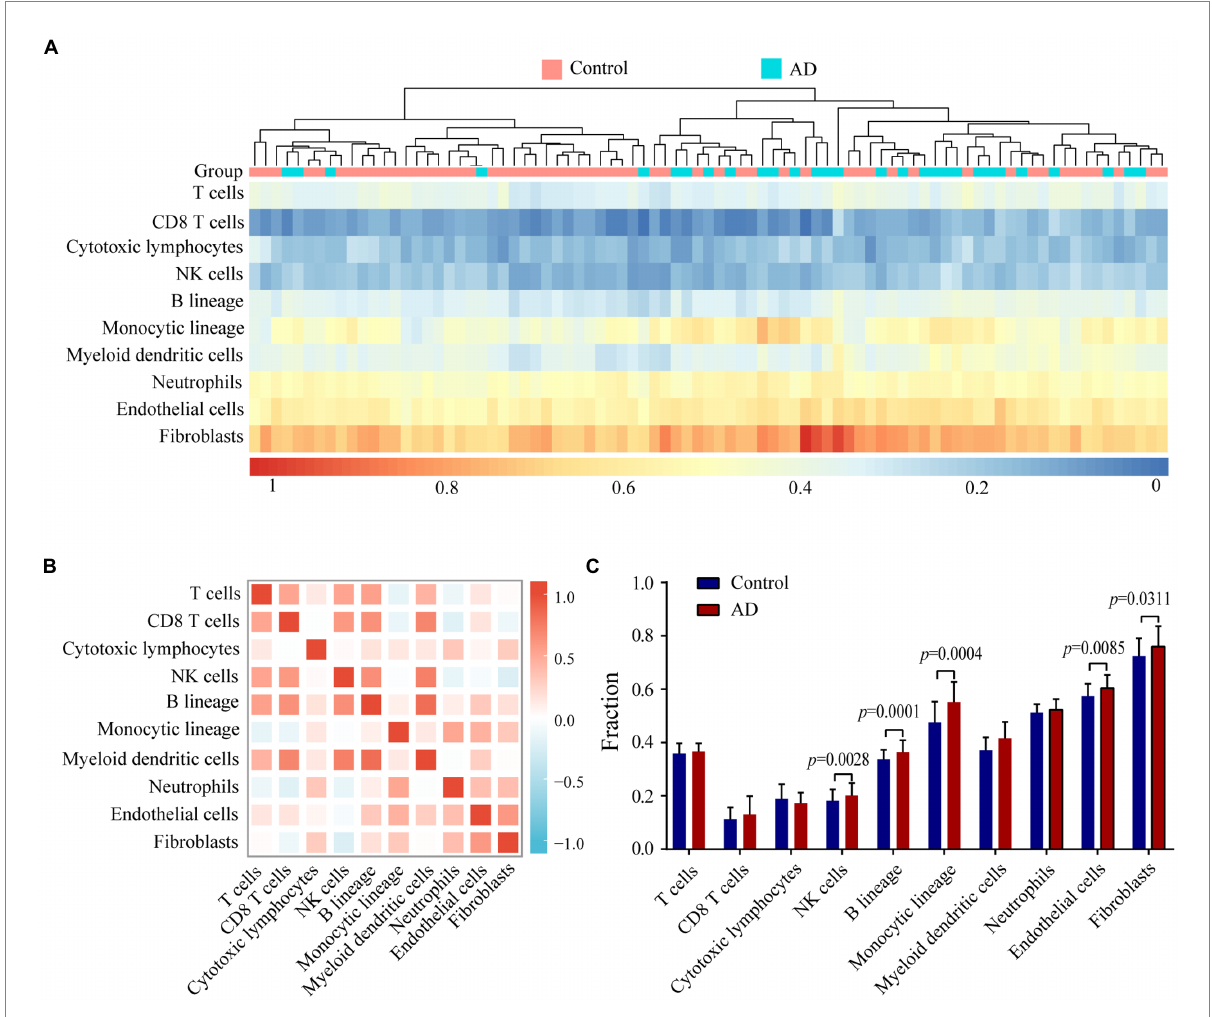
FIGURE 7 Evaluating and identifying the AD immune microenvironment. (A) Heat map presenting results of 8 types of immune cells and 2 types of non- immune stromal cells. (B) Correlations heat map of 8 types of immune cells and 2 types of non-immune stromal cells. Red represents a negative correlation, and blue represents a positive correlation. The darker the color, the stronger the correlation. (C) Bar plot illustrating the proportion of 8 types of immune cells and 2 types of non-immune stromal cells between AD (red) and control (blue)